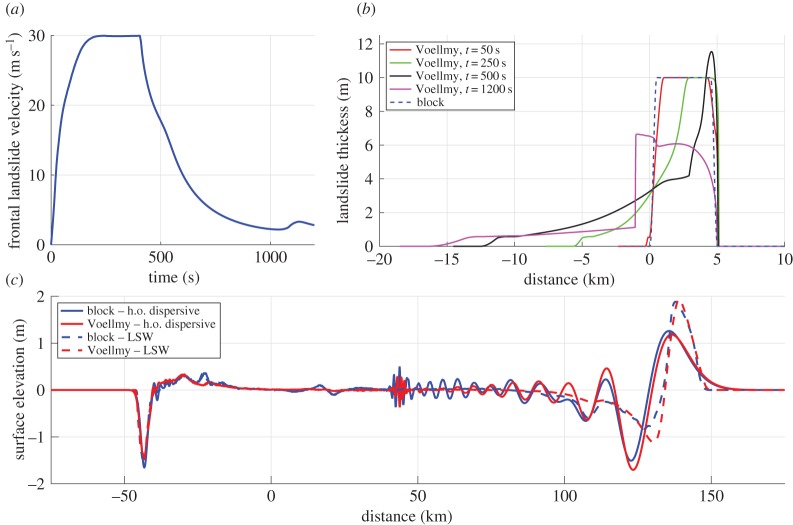
(a) Velocity of the slide front using the Voellmy model. (b) Shape of the deforming landslide for different times. In the figure, we have shifted the frontal slide position to correspond with the one from the block, the purpose is to compare how the deforming landslide deviates from the block with time. (c) Simulated tsunami after t=1200 s. We note that the short frequency waves at x≈40 km are unphysical, but that they do not affect the main wave system.